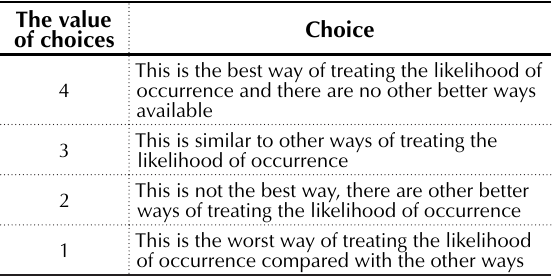
Table 1. The quality of risk treatment